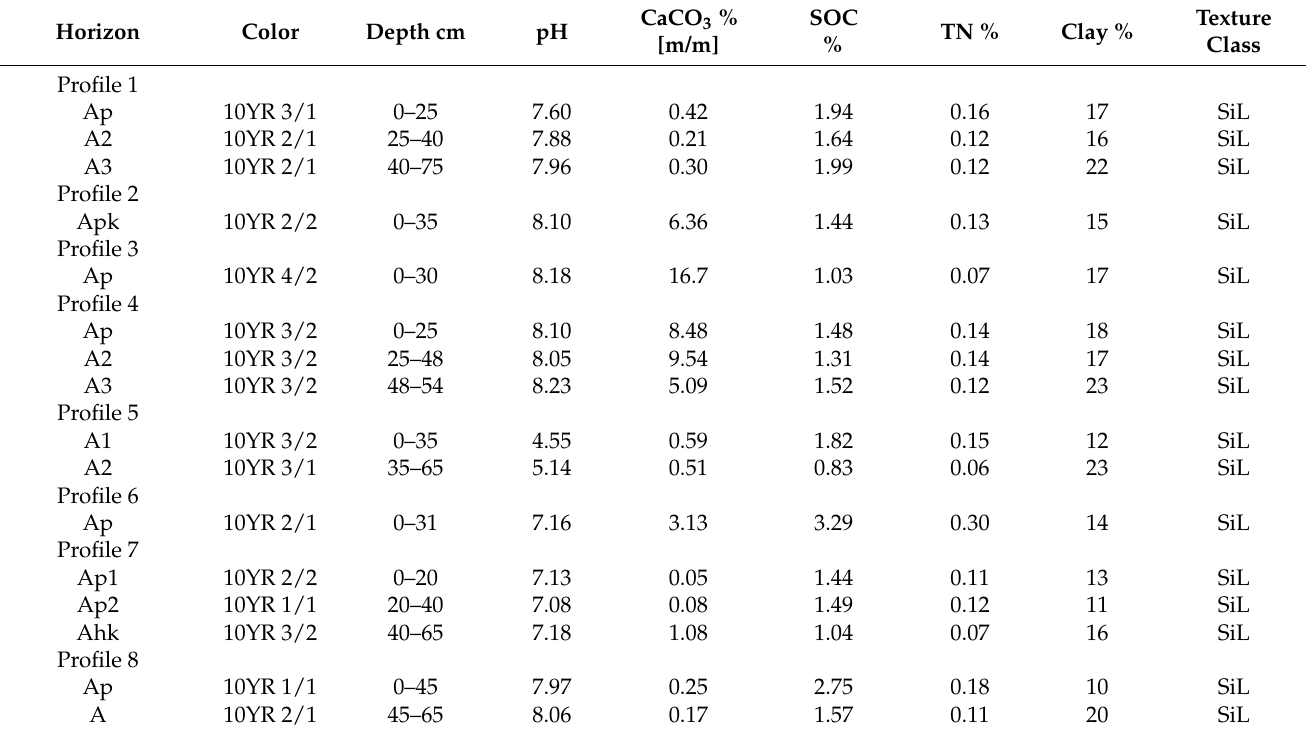
Table 2. Selected physicochemical properties of humus horizons under study (complete list of data for whole profiles is included in Supplementary Materials).